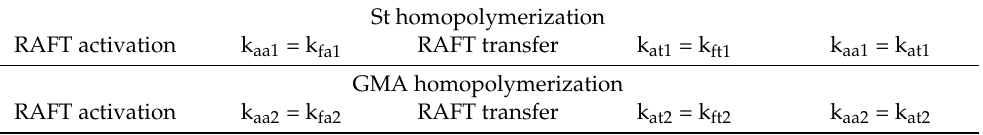
Table 7. Simplifications made about the RAFT activation and transfer kinetic rate